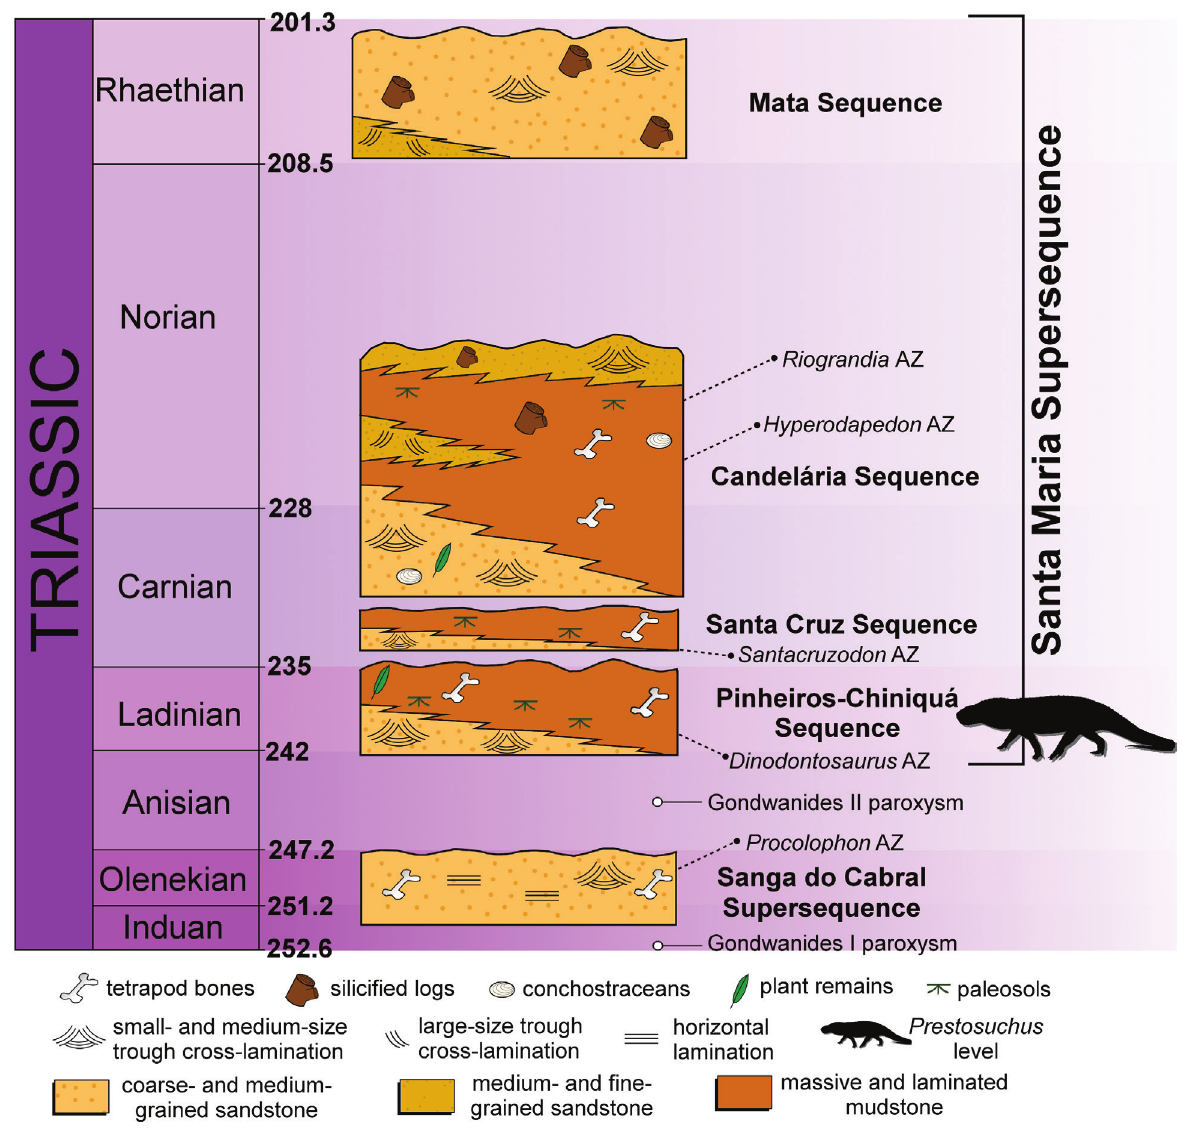
Figure 3 - Stratigraphic framework of the Triassic package from southern Brazil showing the Riograndia AZ; Hyperdapedon AZ; Santracruzodon AZ; Dinodontosaurus AZ; and Procolophon AZ. Rauisuchian outline in black indicates Prestosuchus chiniquensis level. Modified from Zerfass et al. (2003), Desojo et al. (2011) and Horn et al. (2014). Geological timescale follows Gradstein et al.